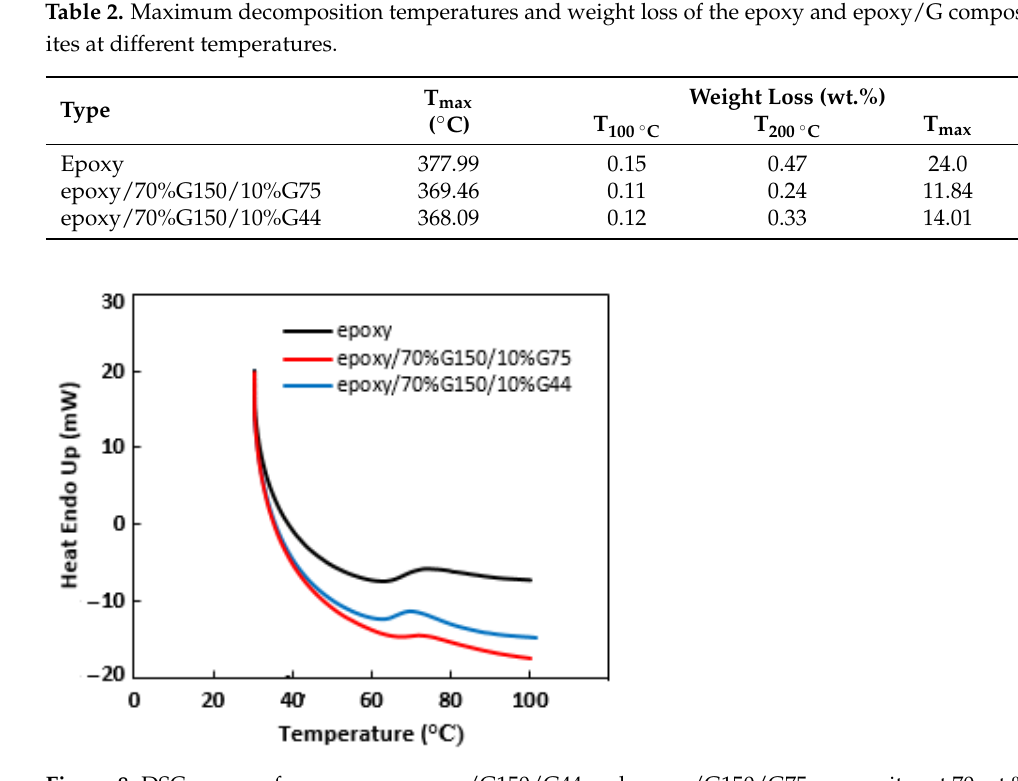
Figure 8. DSC curves of pure epoxy, epoxy/G150/G44 and epoxy/G150/G75 composites at 70 wt.% G150 and 10 wt.% G44 or 10 wt.% G75 prepared at 150 °C for 120 min.